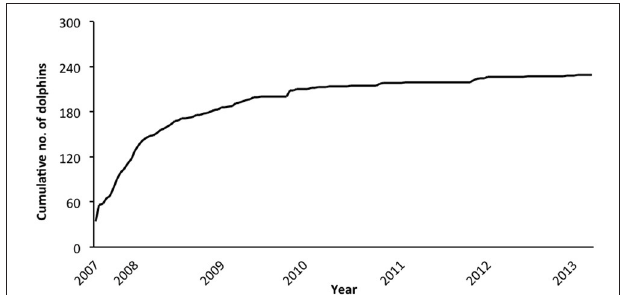
FIGURE 2 | Cumulative discovery curve of the number of adult and juvenile dolphins combined (from excellent and good quality photographs, and highly and moderately distinctive dorsal fins), by secondary period ( n = 139) from March 2007 to April 2013.